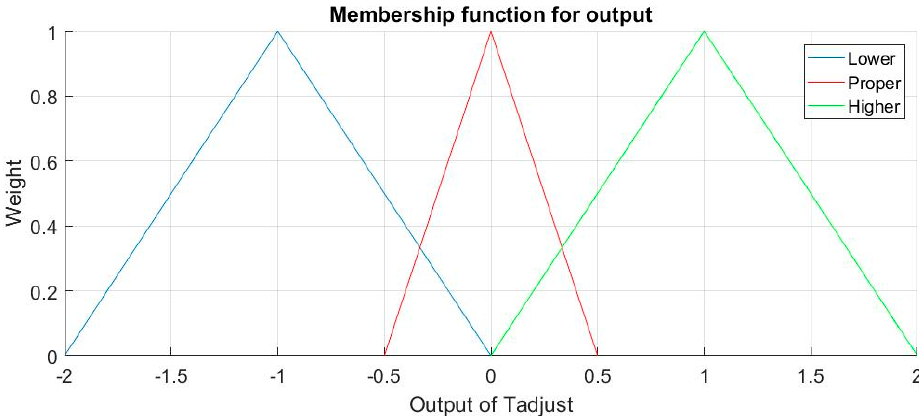
Figure 8. Membership Functions for Output T adjust.